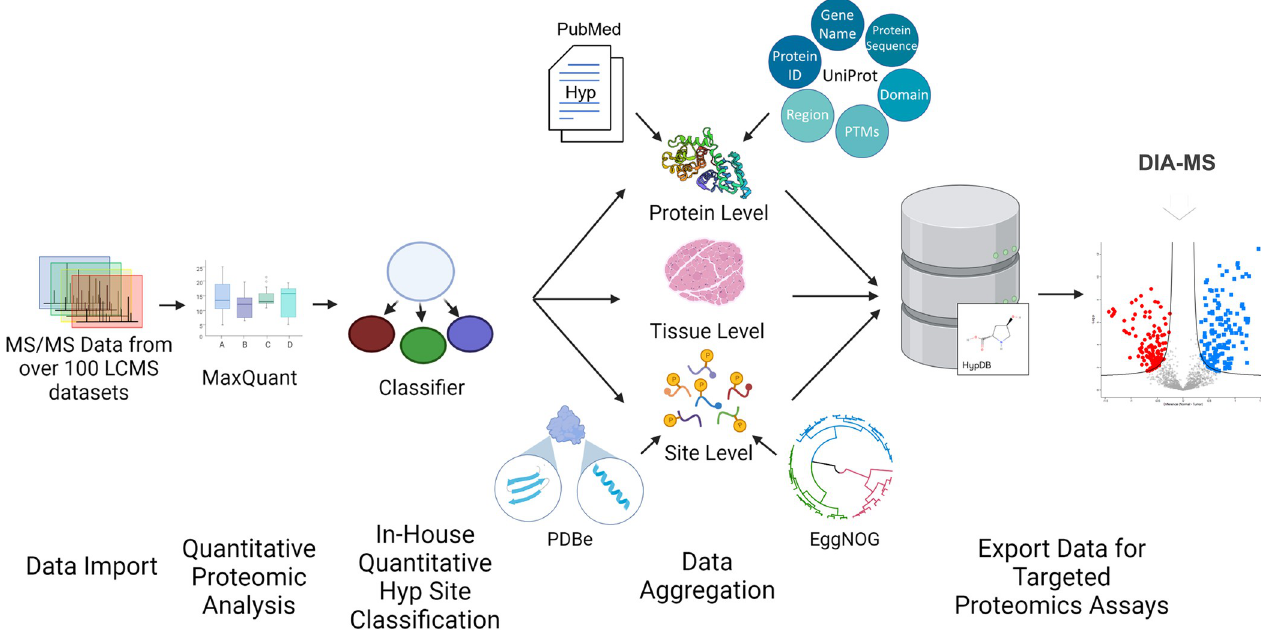
Fig 1. Workflow of establishing HypDB database and webserver. AU : AbbreviationlistshavebeencompiledforthoseusedinFigs 1 ; 2 ; 6 ; and 7 : Pleaseverifythatallentriesarecorrect : HypDB was constructed through deep proteome profiling analysis of human tissues and cell lines, manual literature mining, and integration with UniProt data source. Classification-based algorithm was applied to extract confident identifications, and site-specific bioinformatic analysis with stoichiometry-based quantification revealed the biochemical pathways involved with human Hyp proteome. MS- based Hyp library further enabled DIA-MS quantification of Hyp proteome in cells and tissues. DIA, data-independent acquisition; Hyp, proline